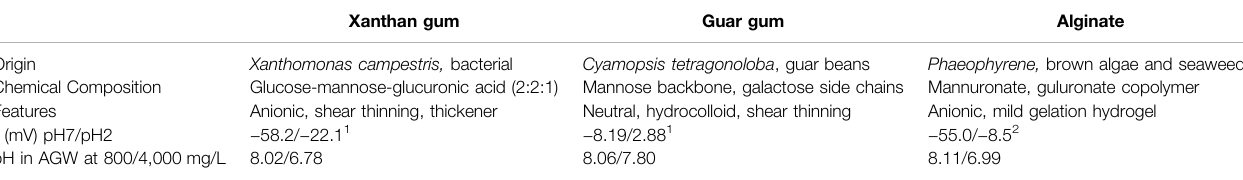
TABLE 1 | Polymer